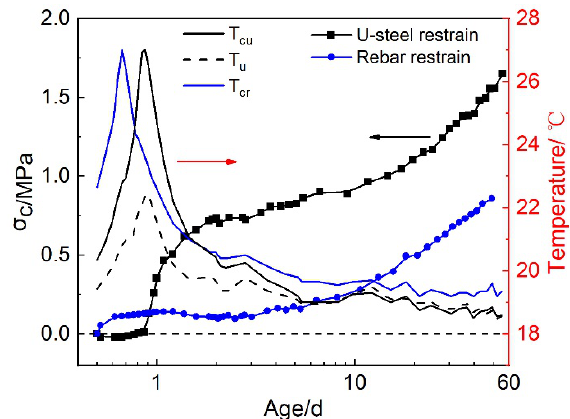
Figure 5. The restrained stresses in HPC under different restraints and the temperature variations in restrained HPC specimens and the U-steel (T cr : the average temperature of HPC specimens and the rebar in rebar restrained stress test; T cu : the average temperature of HPC specimens in U-steel restrained stress test; T u : the average temperature of U-steel in U-steel restrained stress test).